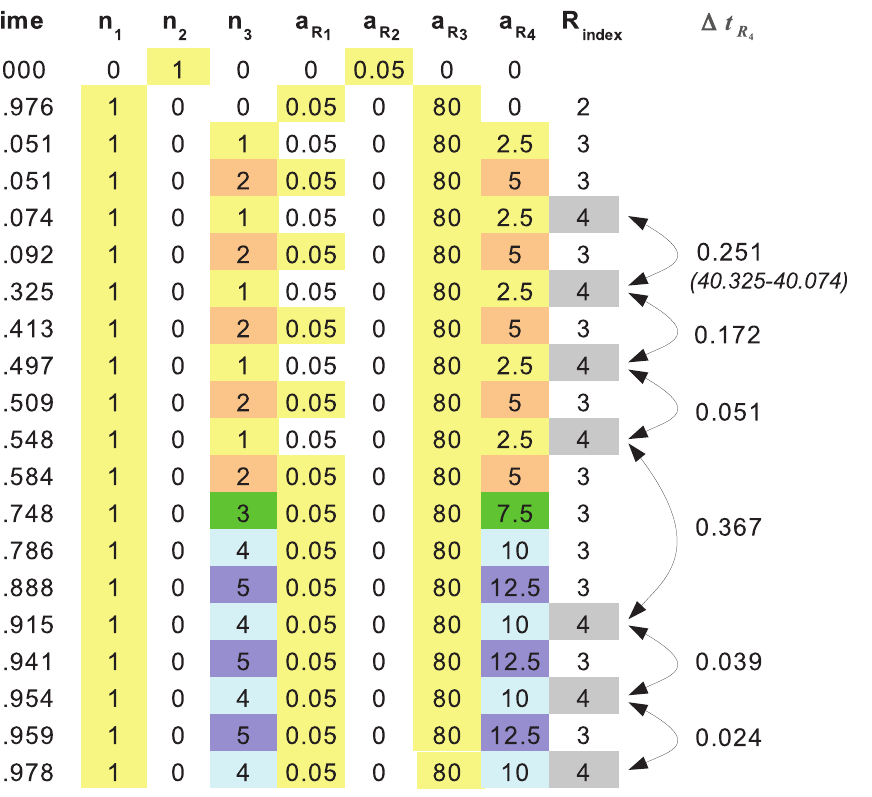
Figure 1. StochPy simulation output. An example of explicit simulation output of StochPy is shown in a table. It reports the number of molecules of each molecular species and the reaction propensities at each time point when a reaction occurs. The time differences between consecutive rows indicate waiting times between reaction events. In the last column, the waiting times for reaction 4, R 4 , are given and they correspond to the time period between consecutive instances of activity of reaction 4.